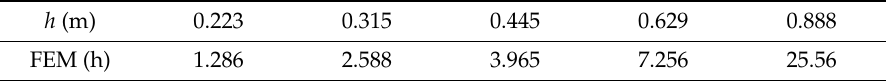
Table 11. Pitch length ( h ) dependence of the time consumption of FEM